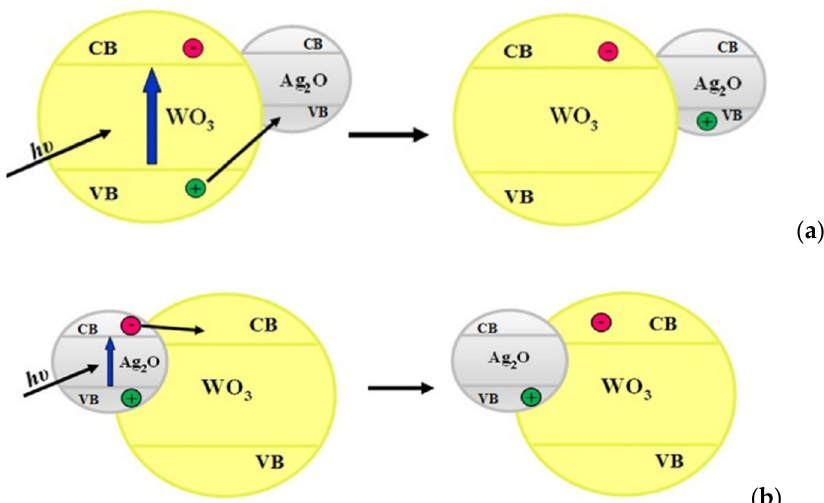
Figure 21. Mechanism of electron-hole pair recombination inhibition. ( a ) When WO 3 absorbs the photons, the photogenerated holes (h + ) are transferred from the valence band of WO 3 to the valance band of surface Ag 2 O in energetically allowed transition. ( b ) When the photons are absorbed by surface Ag 2 O, the photogenerated electrons (e − ) from the conduction band of Ag 2 O are transferred to the conduction band of WO 3 [32]. Reproduced with permission from Hameed et al. Copyright © 2022 Elsevier.